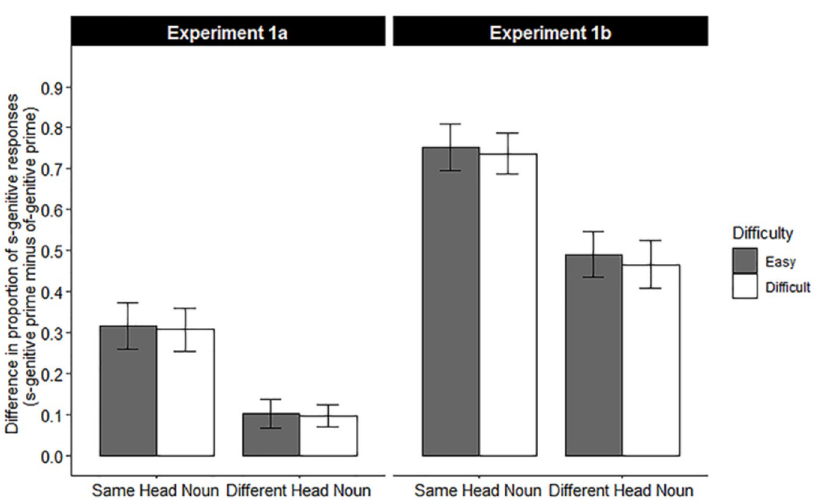
Fig 3. The priming effect (s-genitive production in the s-genitive condition minus that in the of-genitive condition) as a function of head noun condition and problem difficulty in Experiment 1a and 1b. Error bars reflect standard errors calculated for a by-participants